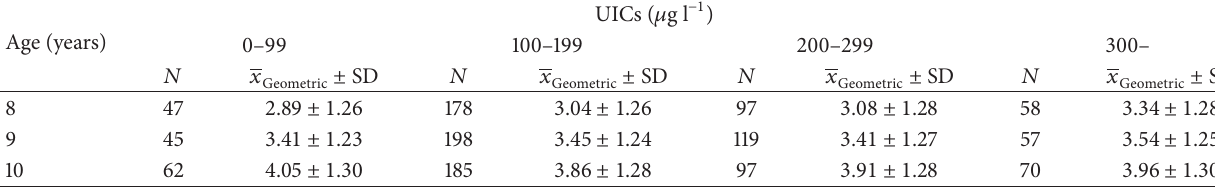
Table 4: Comparison of geometric means of thyroid volume according to group of UICs by